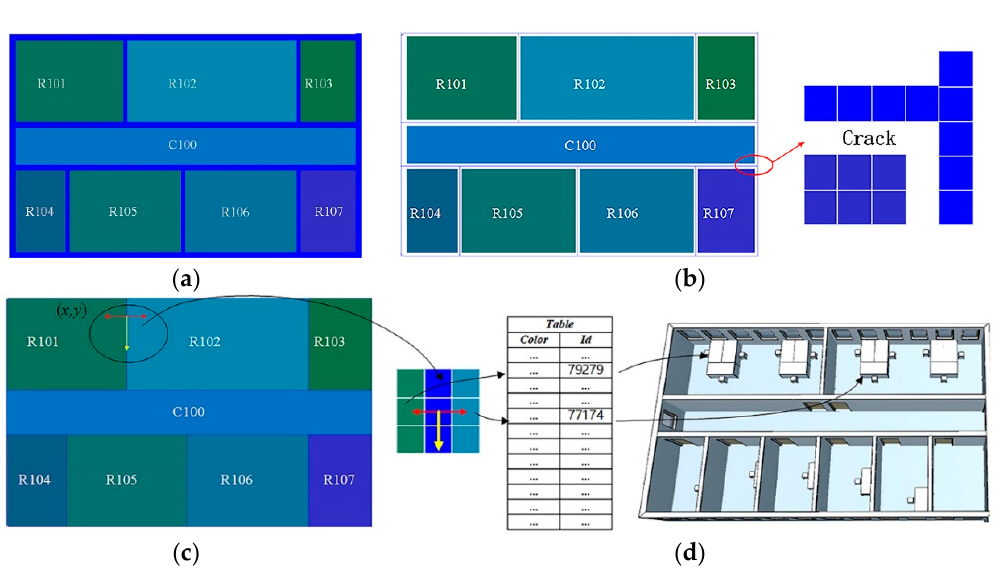
Figure 12. Diagram of horizontal search. ( a ) The part of the rasterized floor plan. ( b ) refined floor plan. ( c ) filling floor plan ( d ) index table and connected BIM model.